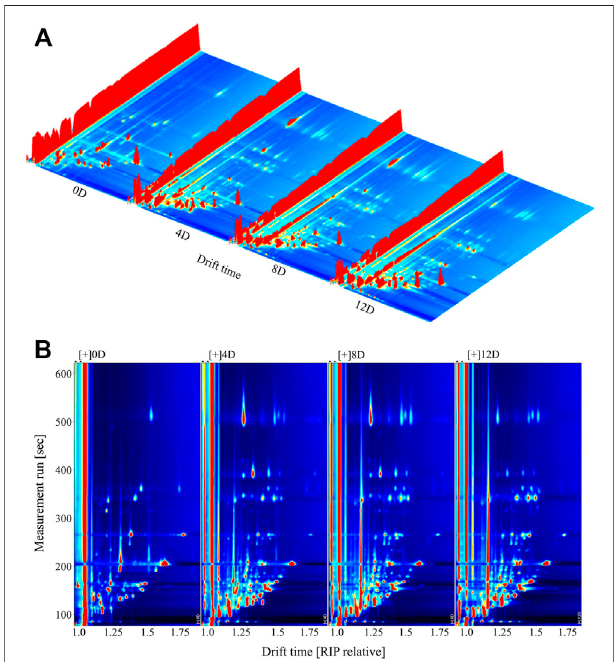
FIGURE 2 | Three-dimensional. (A) and two-dimensional. (B) topographic plots of volatile compounds in fermented mandarin fi sh. Values are obtained from three biological